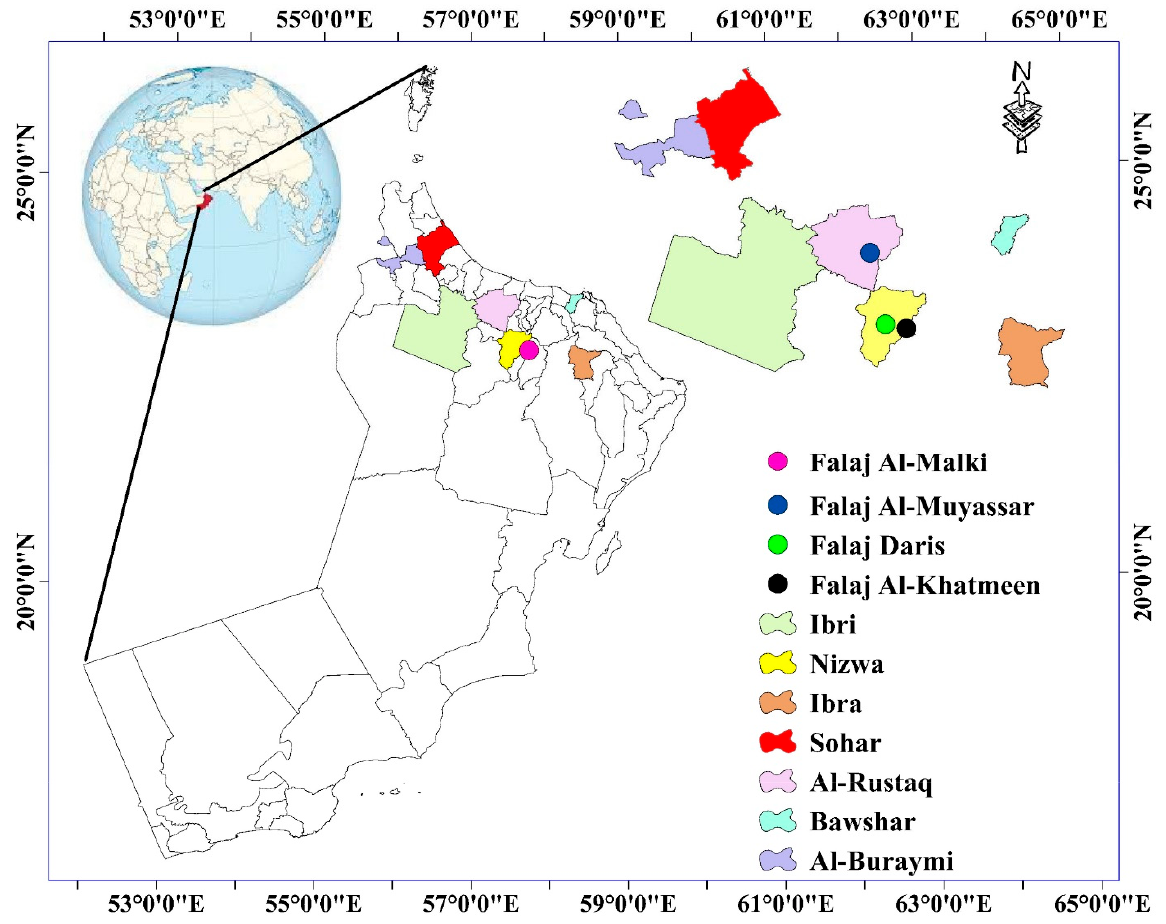
Figure 1. Geographical locations of seven selected cities (Bawsher, Nizwa, Ibra, Ibri, Sohar, Al-Buraymi, and Al-Rustaq) and four important aflaj, namely, Falaj Al-Khatmeen, Falaj Al-Maliki, Falaj Al-Muyasser, and Falaj Daris, in Oman.